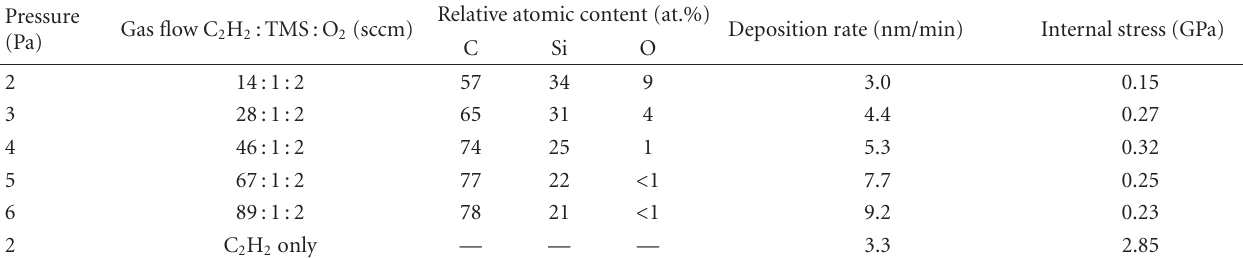
Table 1: Relative atomic content and internal stress of DLC-Si–O films as a function of gas flow.